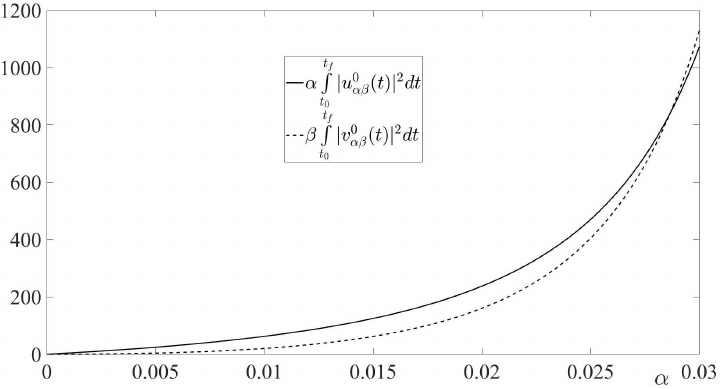
Figure 11. Integral terms of the cost